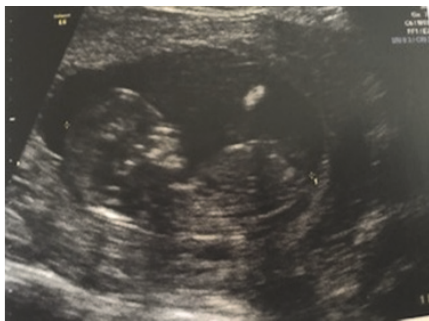
Figure 3: Chorionic villi in the myometrium of uterus, which explain that the placenta percreta is noted at optical